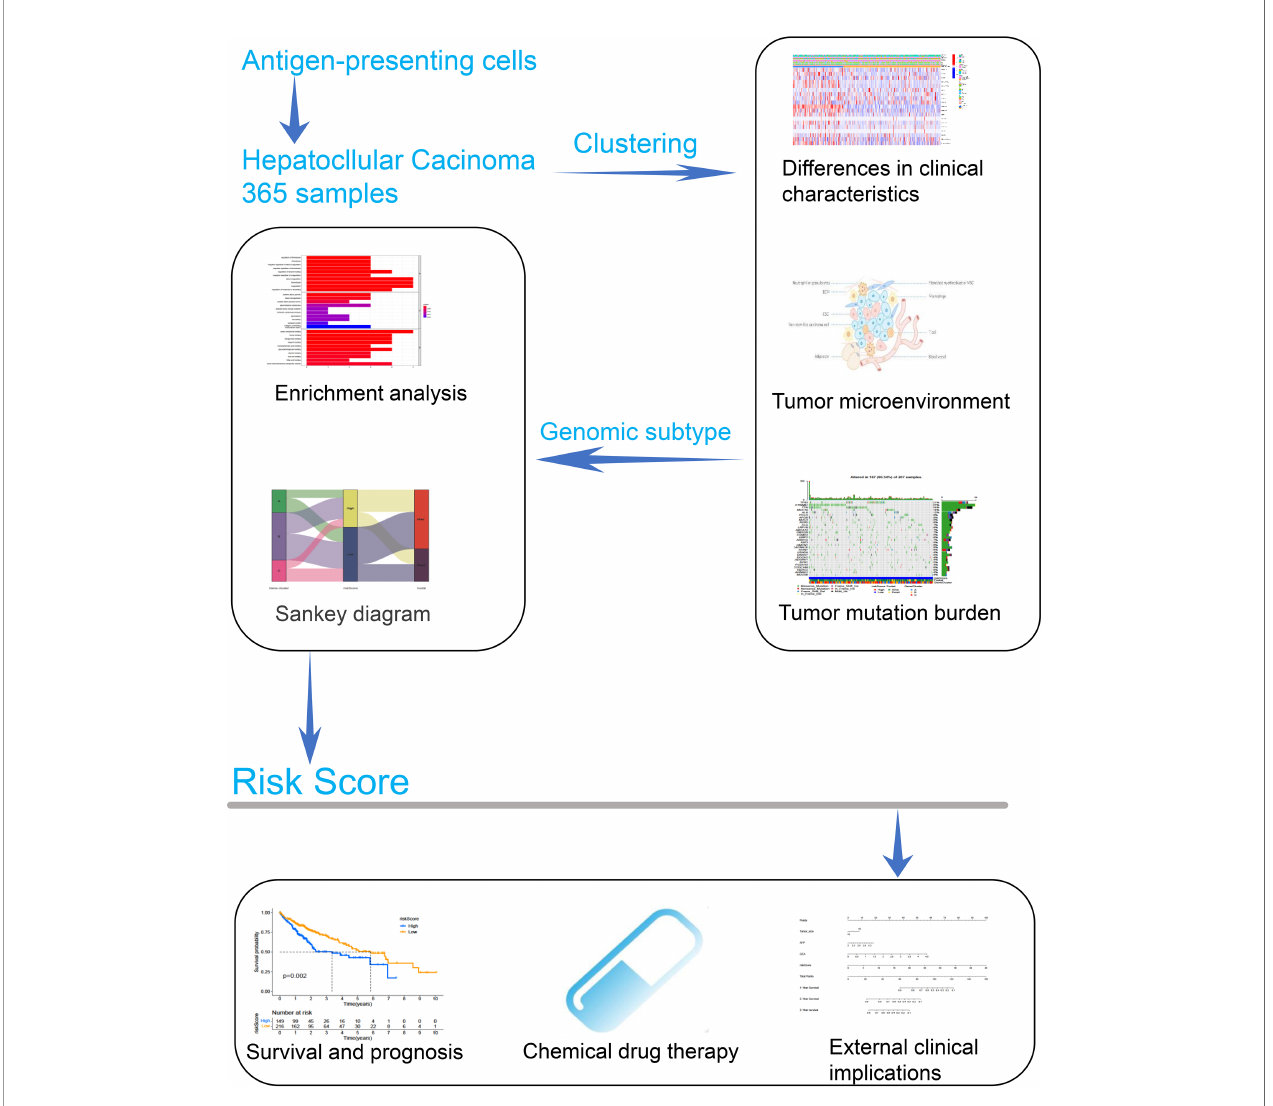
FIGURE 1 | The overall work fl ow of this